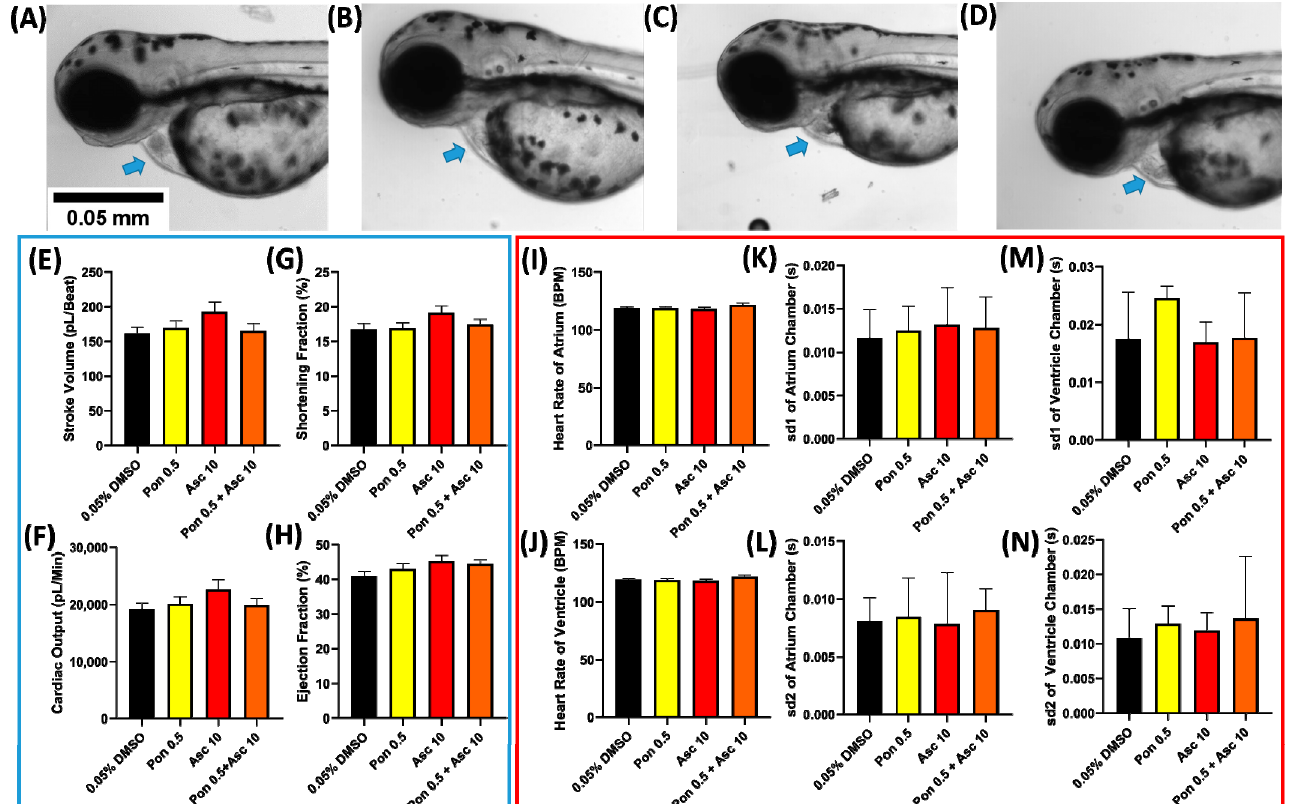
Figure 4. The morphology of 72 hpf zebrafish larvae after acute exposure in 0 ( A ), 0.5 ppm of PON ( B ), 10 ppm of ASC ( C ), and a combination of 0.5 and 10 ppm of PON and ASC ( D ) (blue arrow show the normally developed cardiac chamber). Zebrafish cardiac physiology parameter (( E – H ), blue box) and cardiac rhythm parameter (( I – N ), red box) after exposure to PON and ASC. Data are expressed as mean ± standard deviation, and the statistical significance was calculated using ordinary one-way ANOVA with Dunnet multiple comparison test (degree of significance was set to p < 0.05).